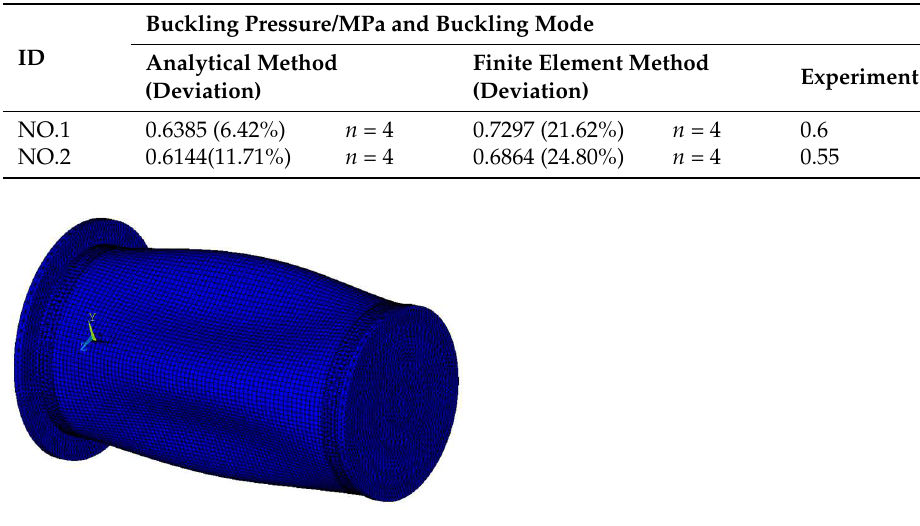
Figure 7. Schematic of the test setup and boundary conditions.